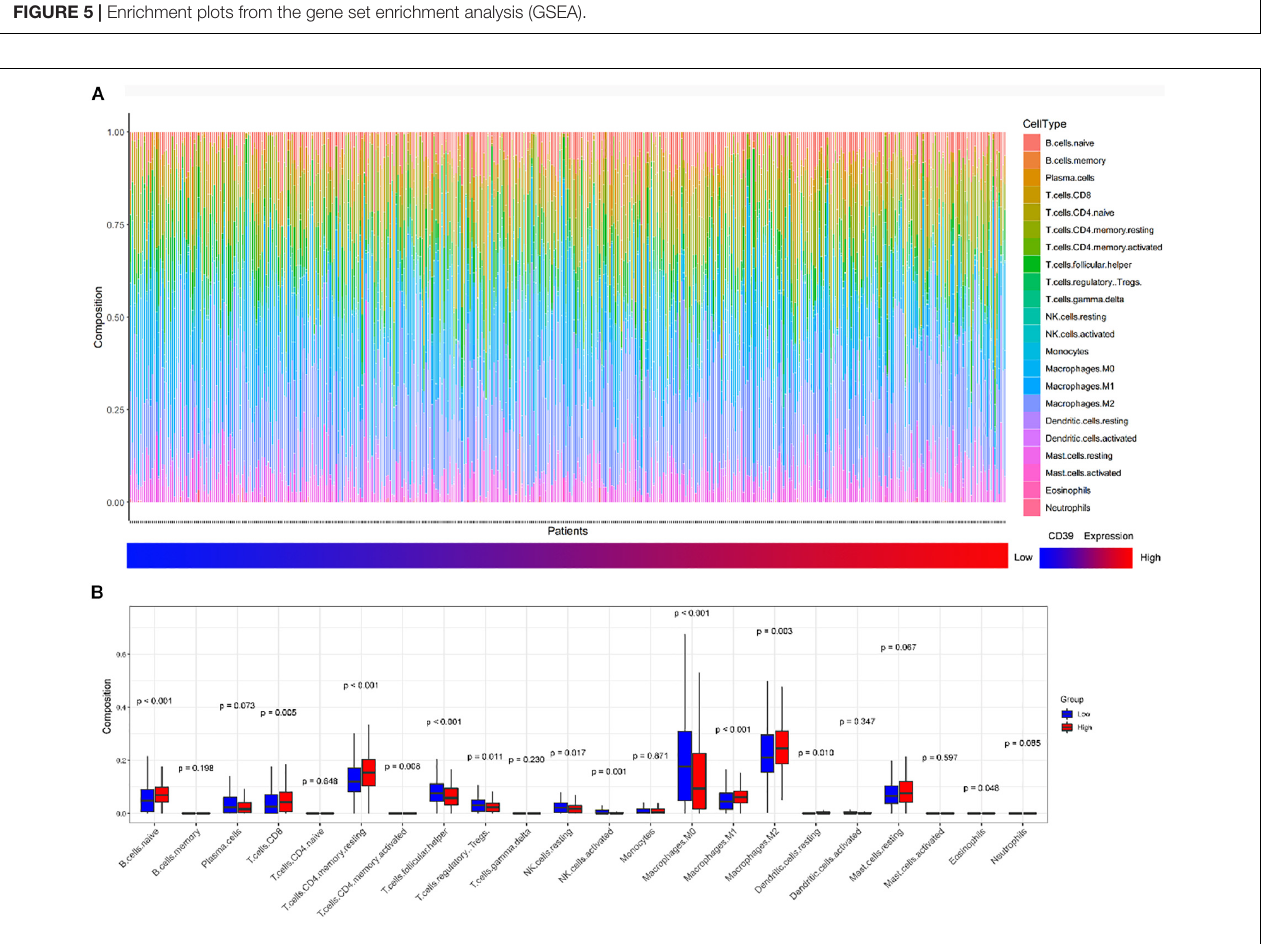
FIGURE 6 | Correlations of CD39 expression with immune infiltration levels in the TCGA cohort. (A) The landscape of immune infiltration in 439 tumor tissues arranged by CD39 expression from low to high. (B) Analysis of differential immune cells between the low and high CD39 expression group in TCGA.